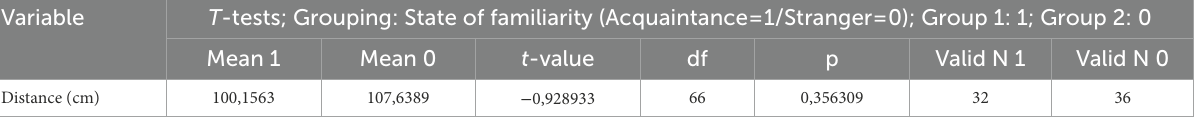
TABLE 2 Influence of previous acquaintance on communication